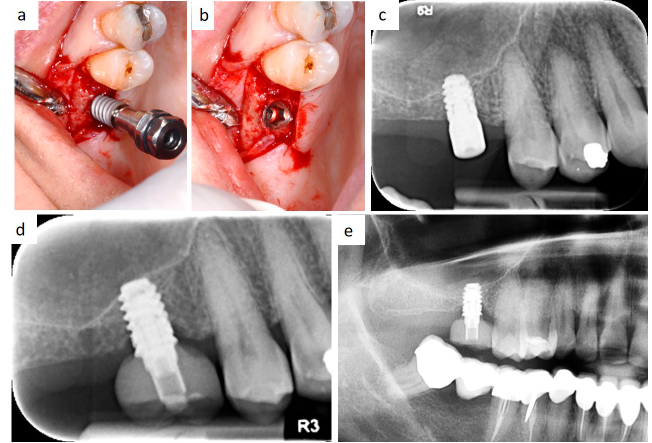
Figure 6. Intraoperative view of implant insertion by muco-periosteal flap elevation ( a , b ); the implant diameter is larger than implant site preparation, thus promoting bone dislocation in the apical direction by the self-tapping capability of the fixture and high primary stability. Radiological follow-up 3 months after insertion ( c ), 2 years after prosthetic rehabilitation ( d ), and after 10 years ( e ).